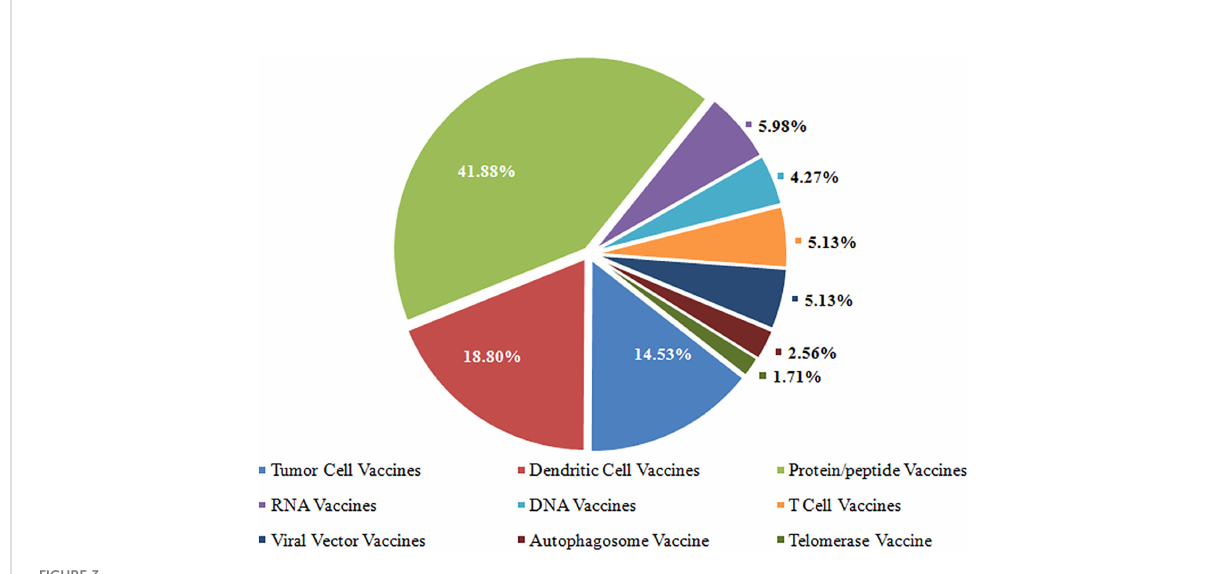
FIGURE 3 The proportion of various types of therapeutic vaccines.